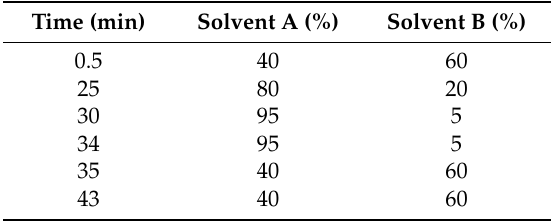
Table 3. The HPLC gradient elution program used for the analysis of biogenic